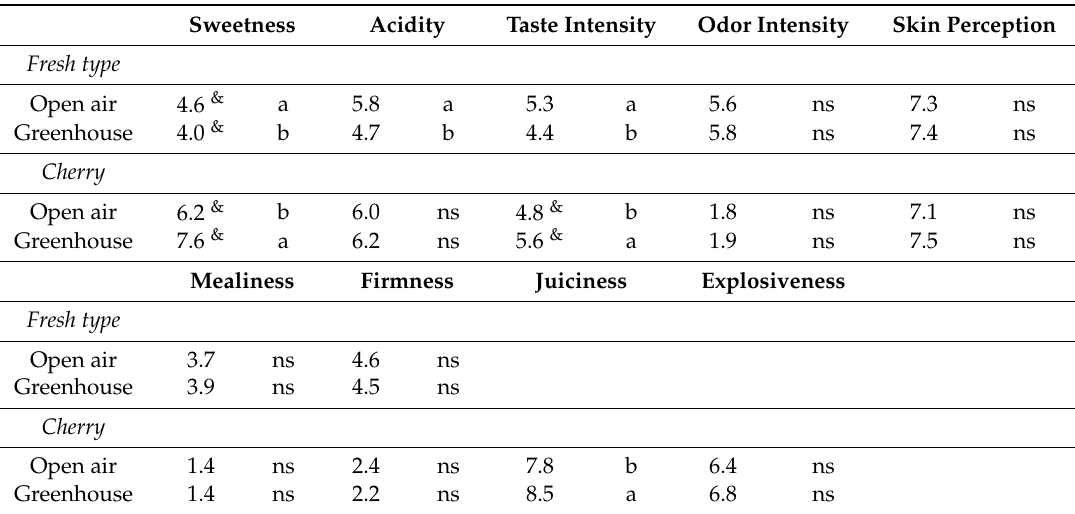
Table 5. Effect of greenhouse vs. open-air cultivation on the sensory traits of cherry and fresh market tomatoes. Within each group and for each trait, different letters indicate significant differences (Student-Newman-Keuls test, at p < 0.05; ns, not significant). & indicates a significant accession*environment interaction ( p < 0.05) within each